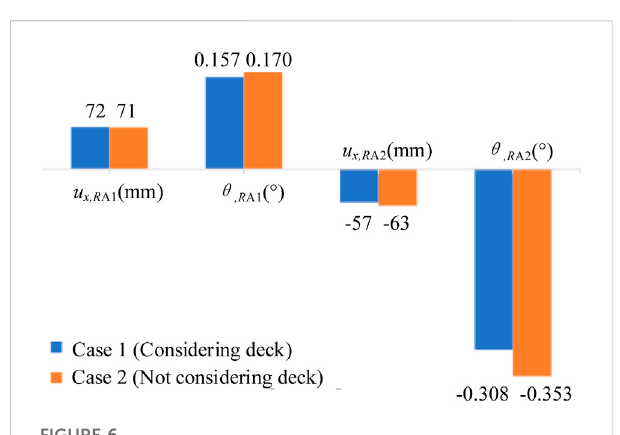
FIGURE 6 Effect of the deck on the residual lateral displacement and rotation of A1 and A2